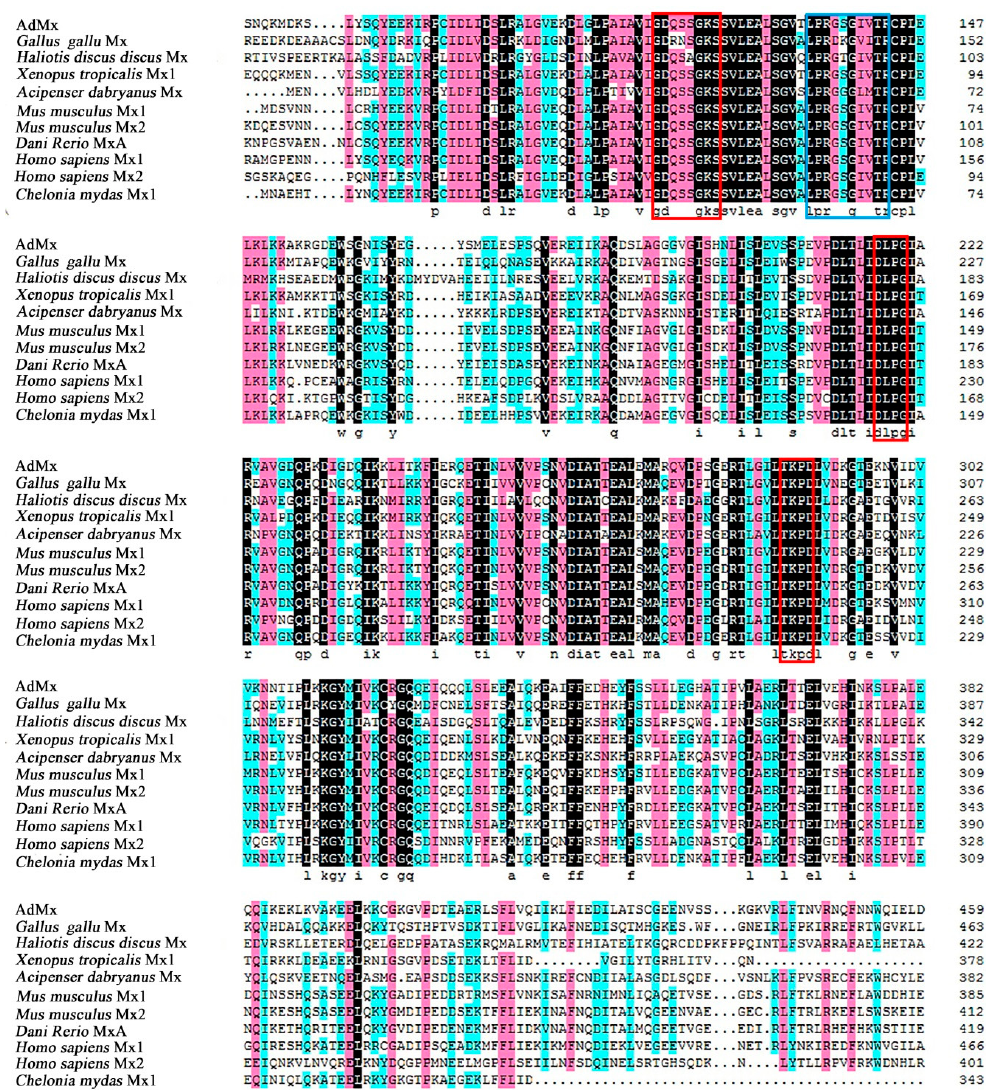
Figure 2. Multi-alignment of AdMx amino acids with other species Mx. Multiple sequence alignment among the amino acids was generated with Clustal W program. Consensus residues are in black, residues that are ≥ 75% identical among the aligned sequences are in pink, and residues that are ≥ 50% identical among the aligned sequences are in blue. The GTP enzyme dynamic protein superfamily tag sequences are indicated by red boxes, and the triplet GTP binding region is indicated by blue box. The GenBank accession numbers of the aligned sequences are obtained from National Center of Biotechnology Information (NCBI) and shown as follows: Gallus gallu Mx: CAA80686.1; Haliotis discus discus Mx: CAA80686.1; Xenopus tropicalis Mx1: XP-012813710; Acipenser dabryanus Mx: QCB64364; Mus musculus Mx1: NP_034976.1; Mus musculus Mx2: NP_038634.1; Dani Rerio MxA: XP-017206546; Homo sapiens Mx1: NP_001171517, Homo sapiens Mx2: NP_002454; Chelonia mydas Mx1: